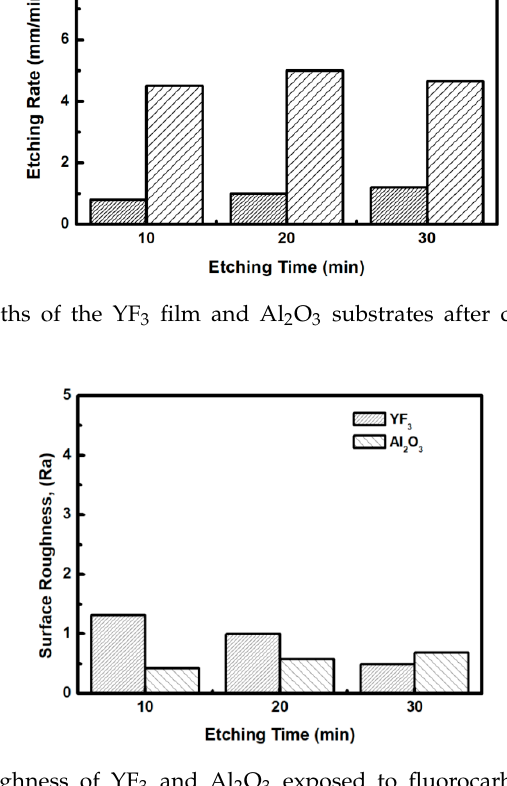
Figure 7. Surface roughness of YF 3 and Al 2 O 3 exposed to fluorocarbon plasma for different etching times.